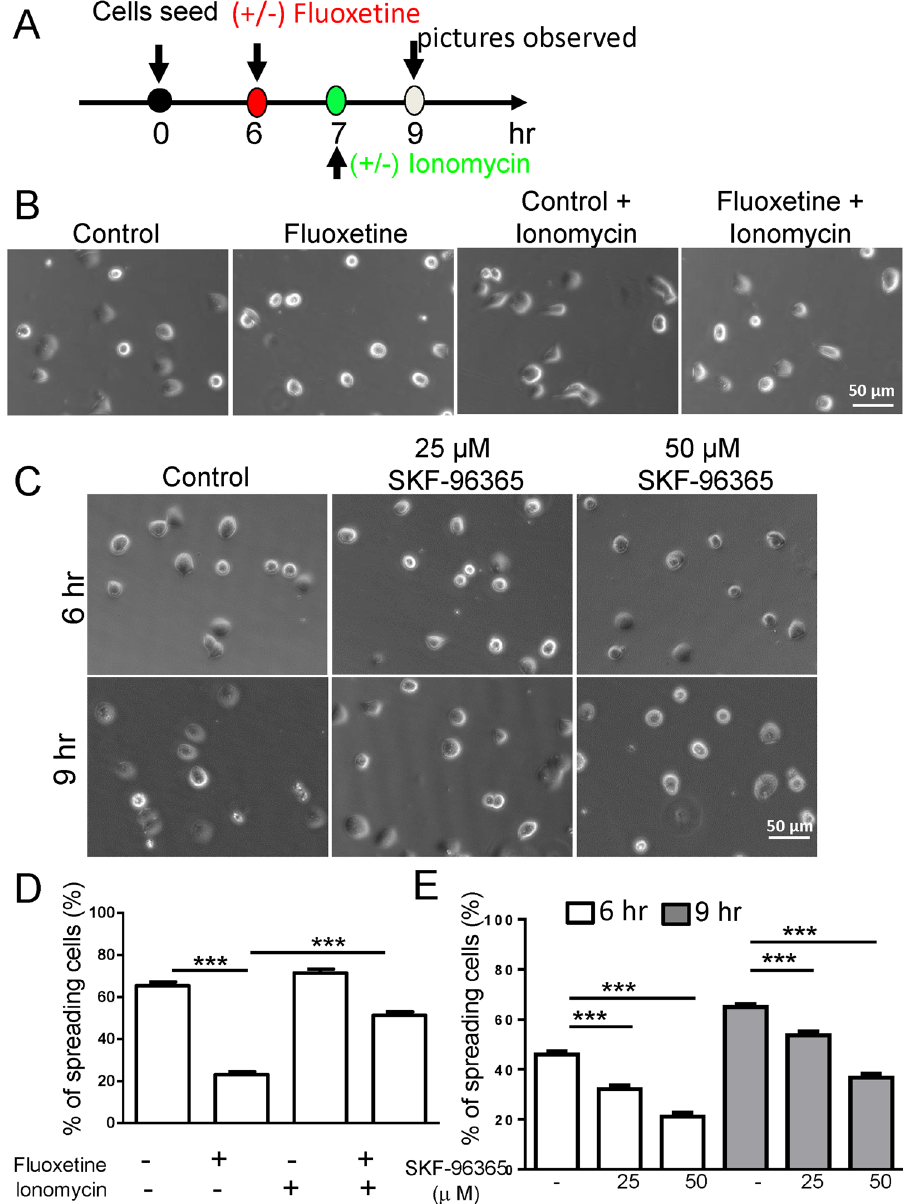
Figure 8. Effects of intracellular Ca 2 + and SOCE activation on spreading of MIN6 cells attached to E-cad/ Fc. ( A ) The protocol to determine whether intracellular Ca 2 + signaling is important for cell-cell adhesion. ( B ) MIN6 cells were seeded on glass slides coated with 5 μ g/ml E-cad/Fc for 6 h, and then treated with or without fluoxetine for 3 h. After one-hour incubation with fluoxetine, cells were treated with or without ionomycin (5 μ M) for 2 h. Cells were rinsed with PBS to remove unattached cells, and then visualized by EVOS FL Auto. At least 100 cells were analyzed for each cell population. Scale bar, 50 μ m ( C ) MIN6 cells were seeded on glass slides coated with 5 μ g/ml E-cad/Fc for 4 or,7 h, and then treated with or without SKF-96365 (25 μ M or 50 μ M) for 2 h. Cells were rinsed with PBS to remove unattached cells, and then visualized by EVOS FL Auto. At least 100 cells were analyzed for each cell population. Scale bar, 50 μ m ( D ) Quantitative analysis of the percentages of spreading cells. Each value represents mean ± SEM from at least three independent experiments. *** p < 0.001 ( E ) Quantitative analysis of the percentages of spreading cells. Each value represents mean ± SEM from at least three independent experiments. *** p <